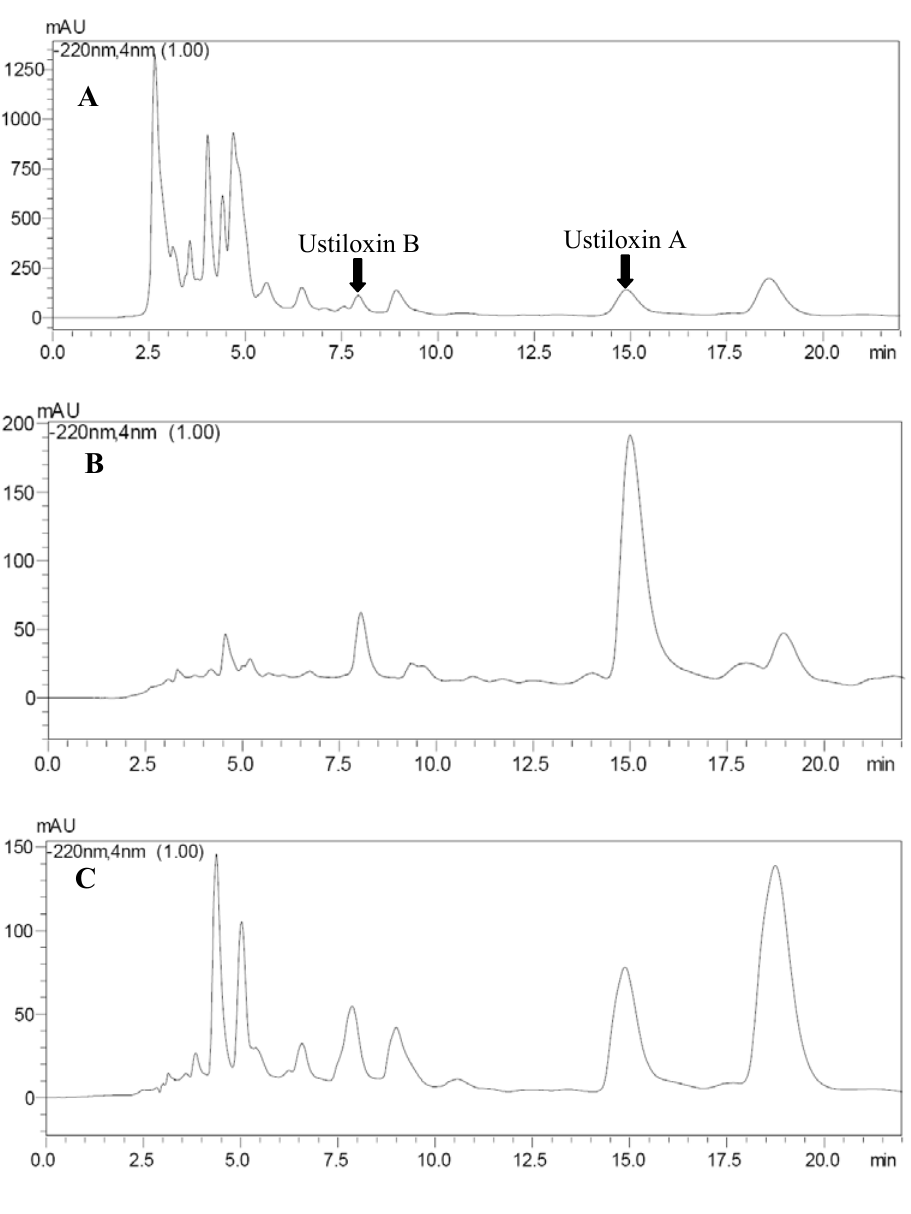
Figure 5. HPLC profiles of the samples untreated ( A ) and treated with resins SP207 ( B ) and SP700 ( C ). Retention time of ustiloxins A and B were 7.90 min and 14.95 min,